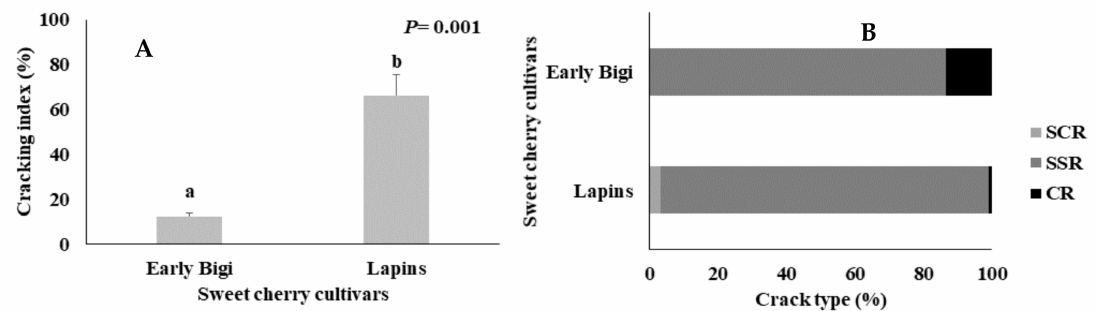
Figure 2. ( A ) Cracking index (%) and ( B ) crack type incidence (%) of two sweet cherry cultivars (Early Bigi and Lapins). SCR—stem cavity region, SSR—stylar scar region, and CR—cheek region. Data are expressed as mean ± standard deviation. Di ff erent letters indicate statistically significant di ff erences ( p < 0.05) between cultivars for each variable, according to Tukey’s